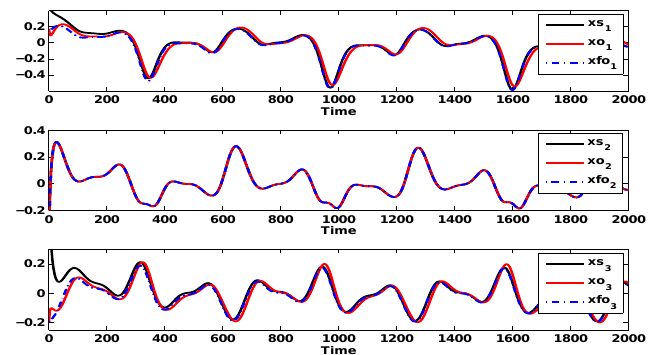
Figure 3. State of the FOTS system and its estimation by FUIO and FOUIO in a free of fault case.